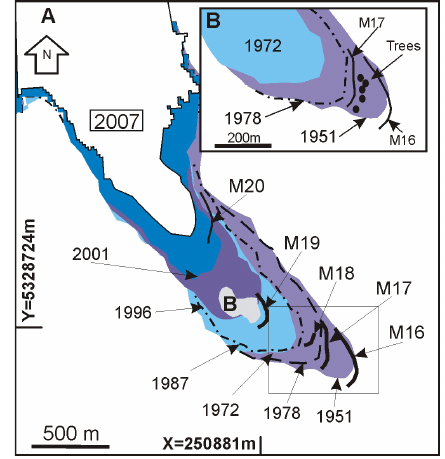
Fig. 3. (A) Fluctuations of the lower portion of Glaciar Esperanza Norte since 1951 derived from remote sensing analyses and histor- ical photographs. The innermost moraines are shown as thick black lines, and the position of the glacier front in 1978 and 1987 is shown by dashed and dash-point black lines, respectively. The lake supe- rior (see Fig. 4a) is shown in grey inside M19. (B) Sketch showing the information used to estimate ecesis at this site, including the lo- cation of the trees sampled on M17 and the position of the glacier in 1951, 1971 and 1978. Coordinates X and Y in UTM 19 S WGS84